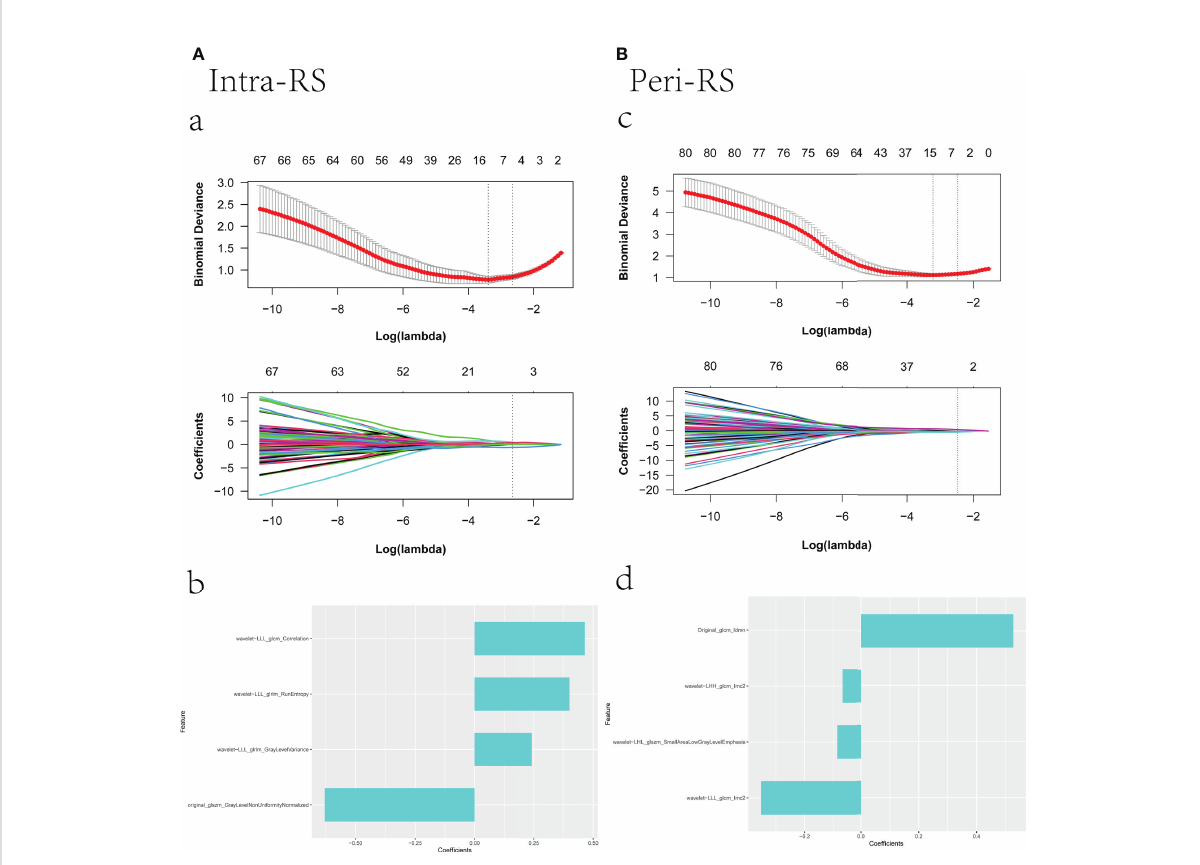
FIGURE 3 Screening radiomics features using lasso; (a): vertical dashed line indicates the best model fi tted when l = 0.070 and Log( l ) equals -2.648, (c): vertical dashed line indicates the best model fi tted when l = 0.084 and Log( l ) equals -2.471; (b), (d) are the selected feature weight coef fi